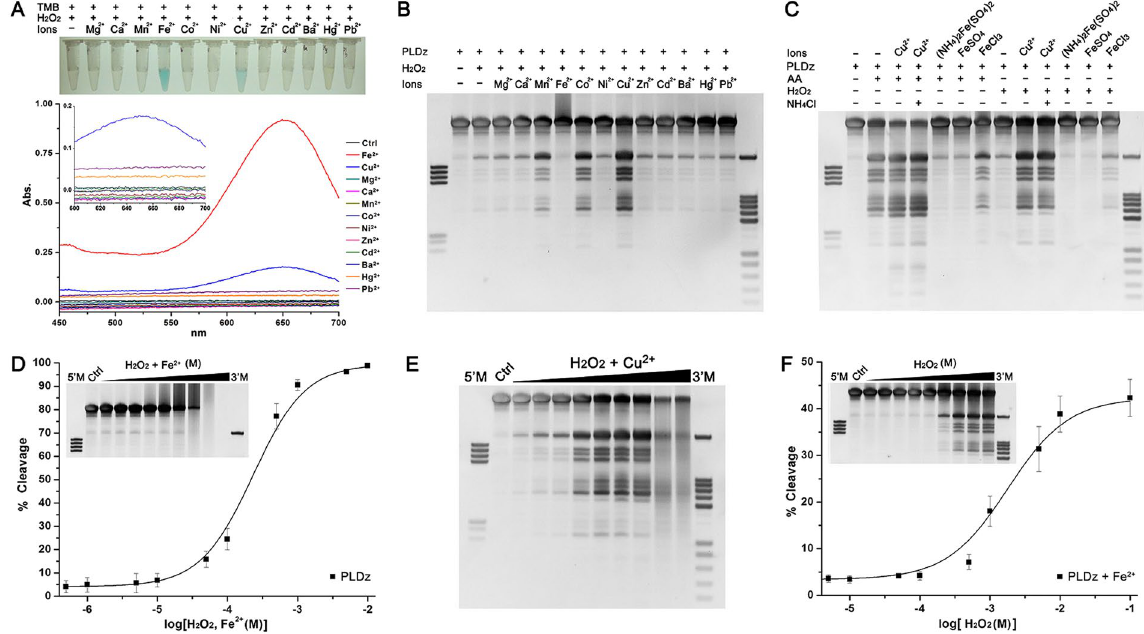
Figure 3. The role of hydroxyl radicals in the catalytic activity of PLDz. ( A ) Comparison of hydroxyl radical generation by treatment with different metal ions in the presence of H 2 O 2 . ( B ) Effects of divalent metal ions/ H 2 O 2 (100 μ M) on the cleavage yield of PLDz. ( C ) Effects of Fe 2 + (100 μ M), Fe 3 + (100 μ M) and NH 4 + (200 μ M) on the cleavage yield of PLDz. ( D ) Effects of Fenton reagent (Fe 2 + /H 2 O 2 , 1 μ M–0.01 M) on the cleavage yield of PLDz. ( E ) Effect of Cu 2 + /H 2 O 2 concentration (1 μ M–0.01 M) on the cleavage yield of PLDz. ( F ) Effect of H 2 O 2 concentration (10 μ M–0.1 M) on the cleavage yield of PLDz in present of 100 μ M Fe 2 + . Reaction condition: 300 mM NaCl and 50 mM Tris-HCl (pH 7.0) at 23 °C for 2 hr. The error bars represented the standard deviations from three repeated measurements. Cropped gels are used in Fig. 3B–F, their full-length gels are presented in Supplementary Figure